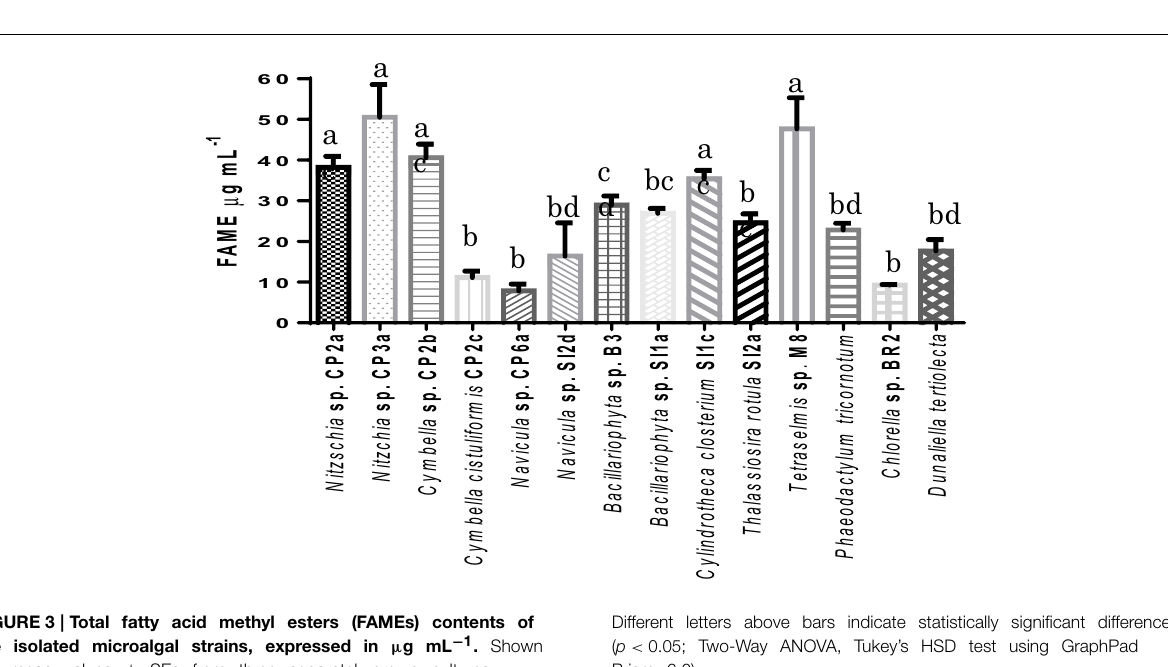
FIGURE 3 | Total fatty acid methyl esters (FAMEs) contents of the isolated microalgal strains, expressed in µ g mL − 1 . Shown are mean values ± SEs from three separately-grown cultures.